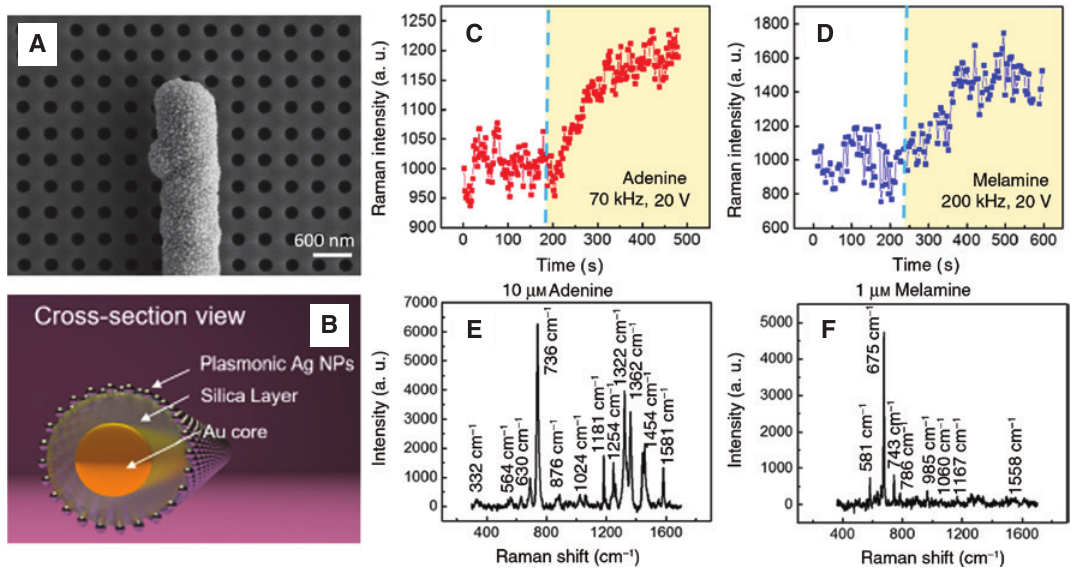
Figure 31: Integrated hybrid plasmonic-photonic architecture for electrokinetic manipulation and biochemical detection.